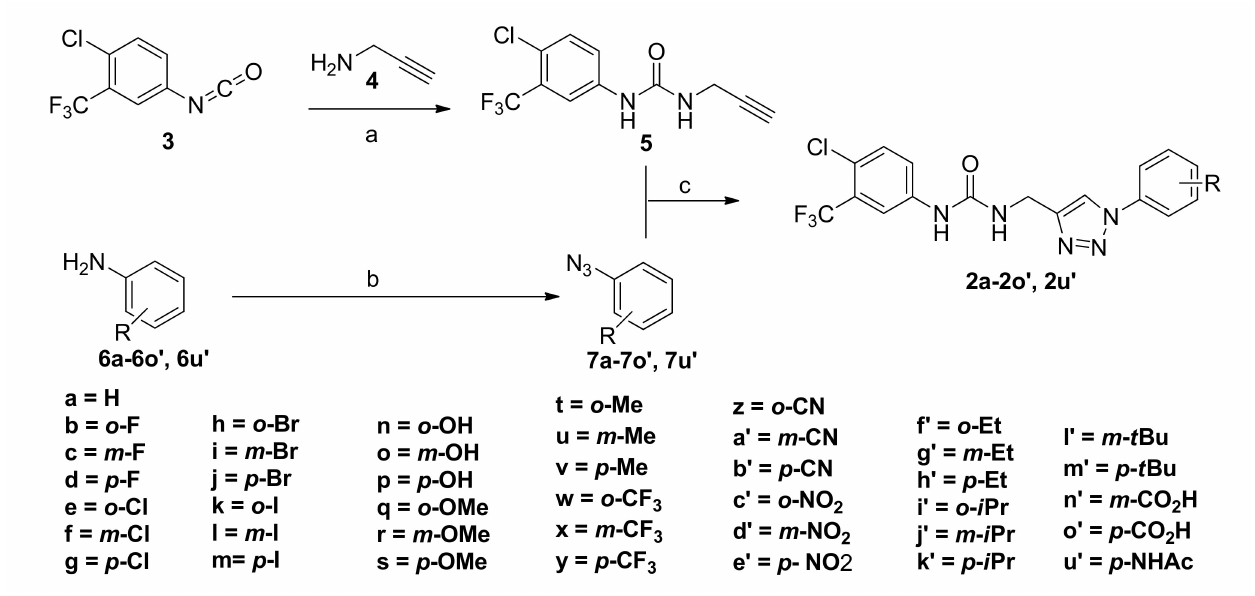
Scheme 2. The synthesis route to triazole-cored analogs 2a – 2o’ and 2u’. Reagents and